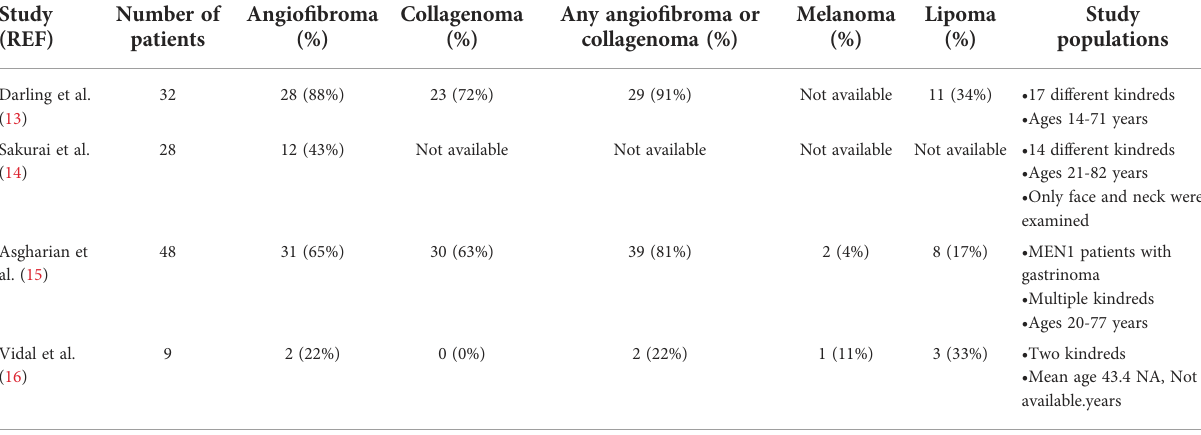
TABLE 1 Prevalence of cutaneous and adipose tissue neoplasms in patients with MEN1 having a comprehensive dermatologic